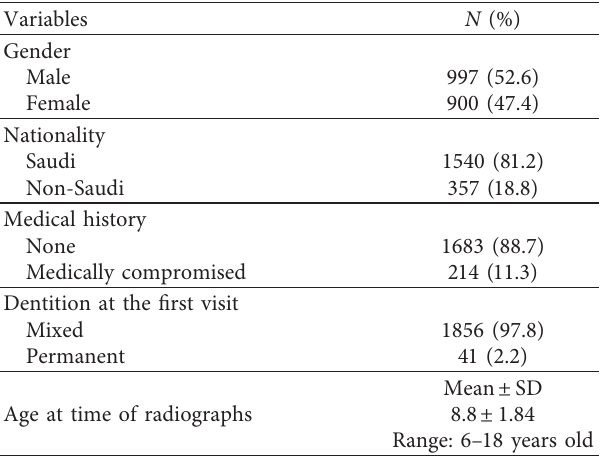
Table 1: Demographic distribution of study subjects ( N �